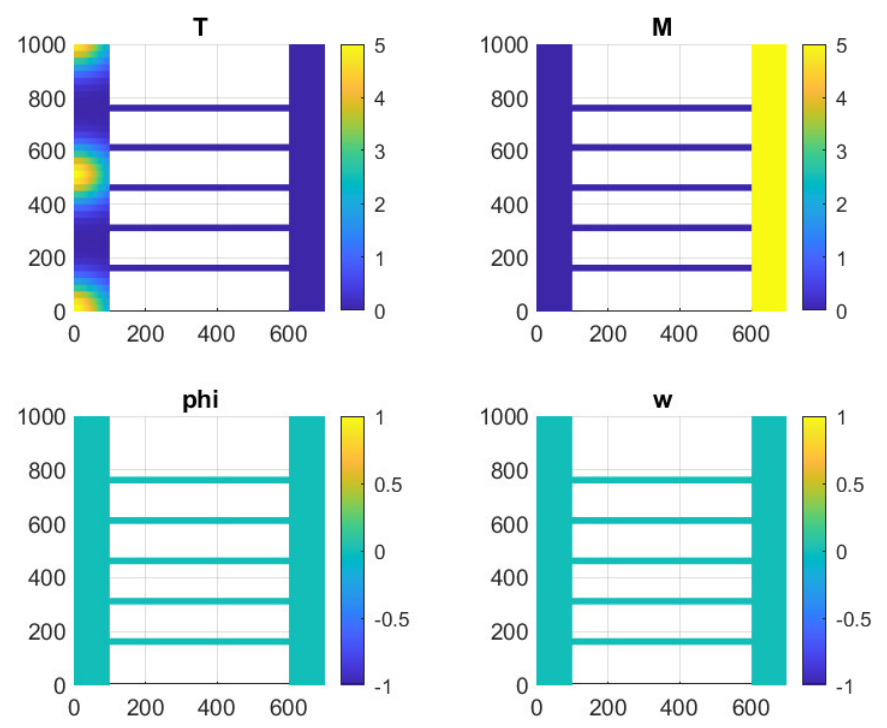
Figure 8. Treated case. Initial distribution for the model (3)–(7) at time t =